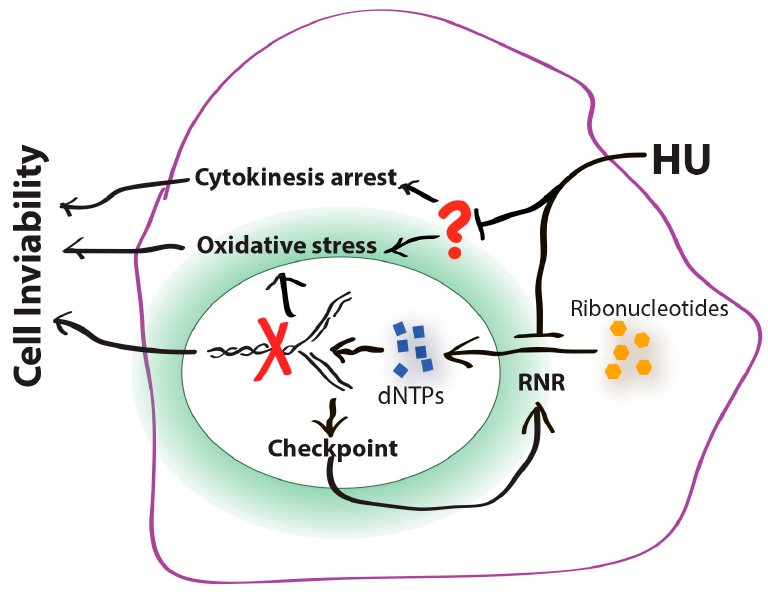
Figure 3. The cell ‐ killing mechanisms of HU. HU inhibits its primary cellular target ribonucleotide reductase (RNR), which decreases the deoxyribonucleotide triphosphate (dNTP) levels and slows the movement of DNA polymerases at the forks ( red cross). Slowed forks activate the DNA replication checkpoint. Activated checkpoint stimulates RNR to increase the dNTP production for DNA